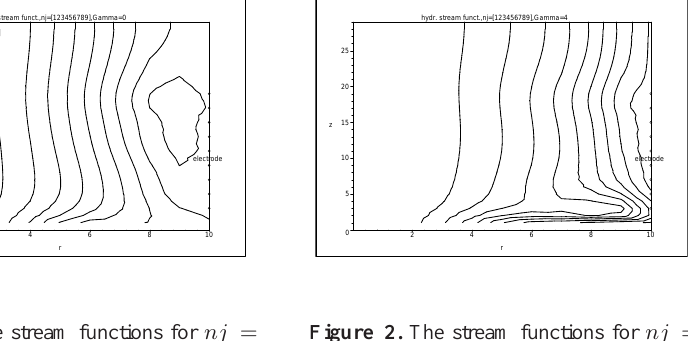
Figure 2. The stream functions for nj = [123456789] , ψ ∈ (0 . 00 , 0 . 17) , Γ = 4 .